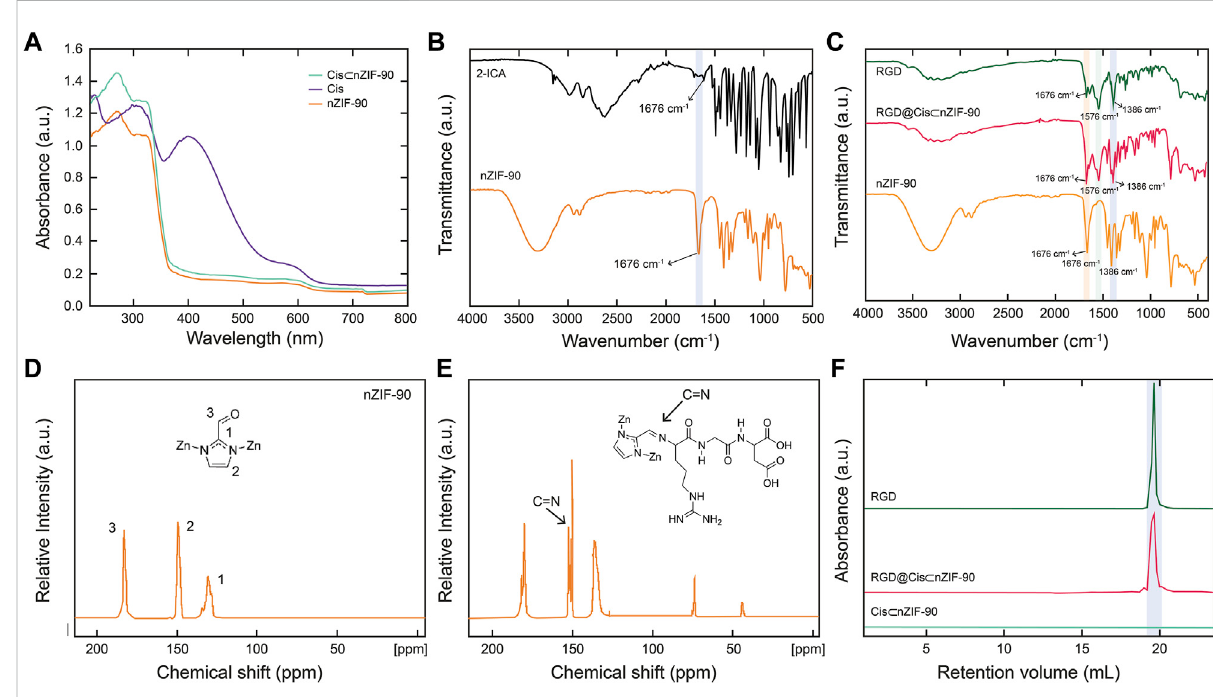
FIGURE 2 (A) Solid-state UV-vis of nZIF-90 (orange), Cis (purple) and Cis ⊂ nZIF-90 (green). (B) FT-IR spectra of 2-ICA linker (black) compared with nZIF- 90. (C) FT-IR spectra comparison of nZIF-90, RGD@Cis ⊂ nZIF-90 (red) and RGD (dark green). (D,E) Solid state 13 C CP-MAS NMR spectra of nZIF-90 (D) and RGD@ZIF-90 (E) . (F) Size exclusion chromatograms comparing acid-digested Cis ⊂ nZIF-90 and RGD@Cis ⊂ nZIF-90 with the chromatogram of free